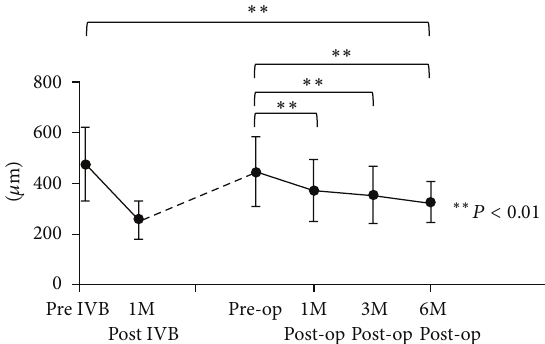
Figure 2: Changes in mean central retinal thickness. Mean CRT was significantly improved after 1 month of IVB compared to the baseline. Mean CRT was significantly improved at 1 month after vitrectomy, compared to the pre-op CRT ( ∗∗ 𝑃 < 0.01 ). CRT: central retinal thickness; post IVB: 1 month from IVB.